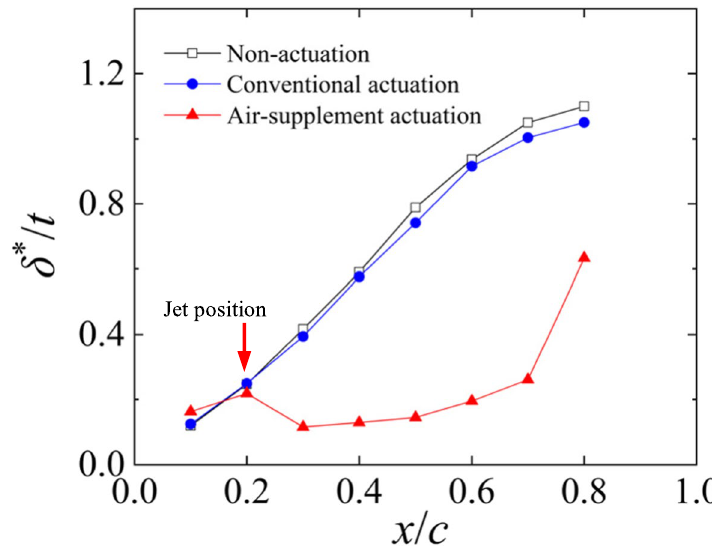
Fig. 10 Boundary layer displacement thickness under different actuation states at α